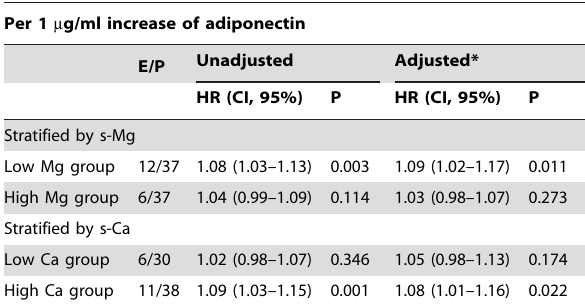
Table 5. Association of adiponectin with all-cause mortality stratified by serum Mg and dialysate